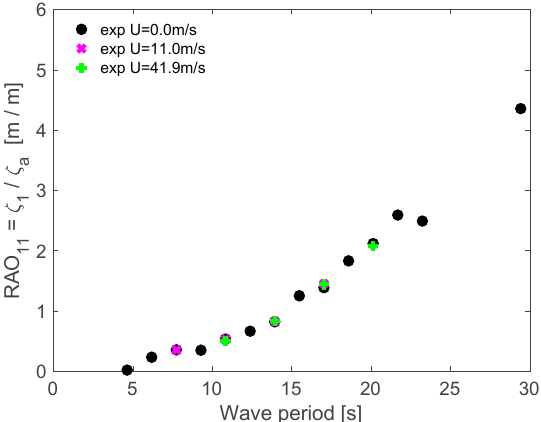
Figure 14. Effect of the incident wind speed on the experimental RAO surge motion results.